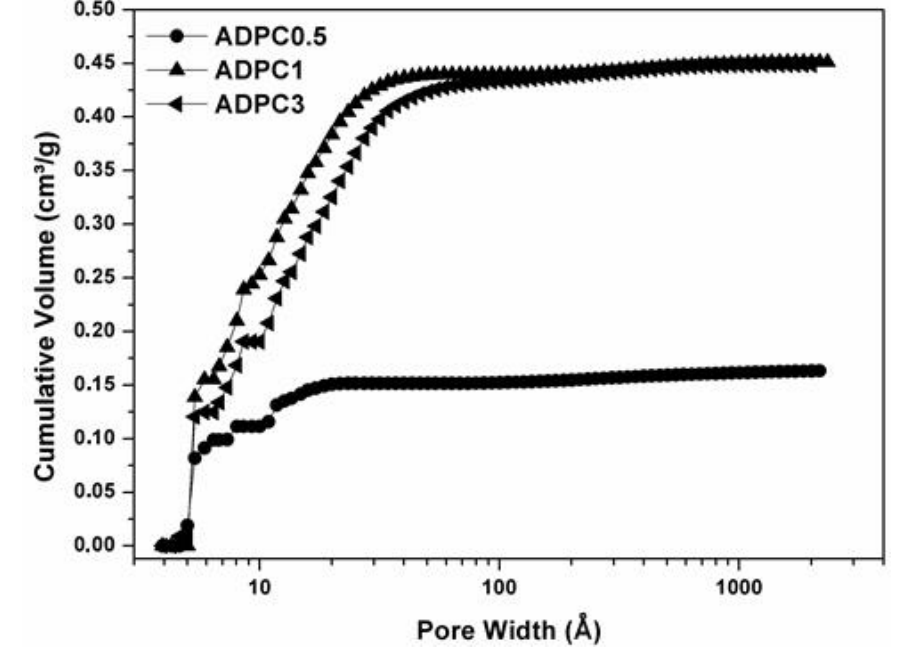
Energies 2020 , 13 , x FOR PEER REVIEW Figure 5. Cumulative pore volume of the analyzed samples. Figure 5. Cumulative pore volume of the analyzed samples.